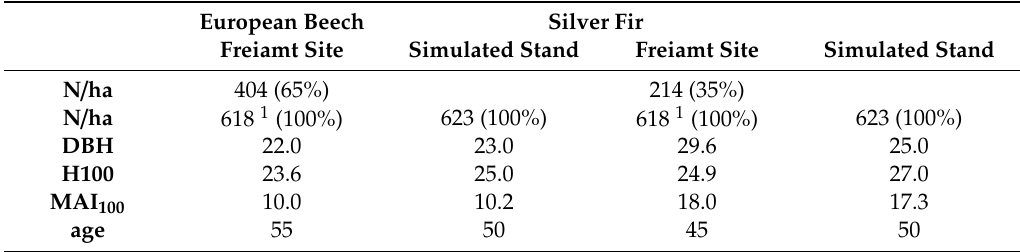
Table 1. Inventory results of the Freiamt experimental site with tree density (N / ha) and species share 65% and 35%—mean stand age and mean annual increment (MAI) (both determined with the yield table of Bösch (2001) and the measured heights of the 100 tallest trees H100). European Beech Silver